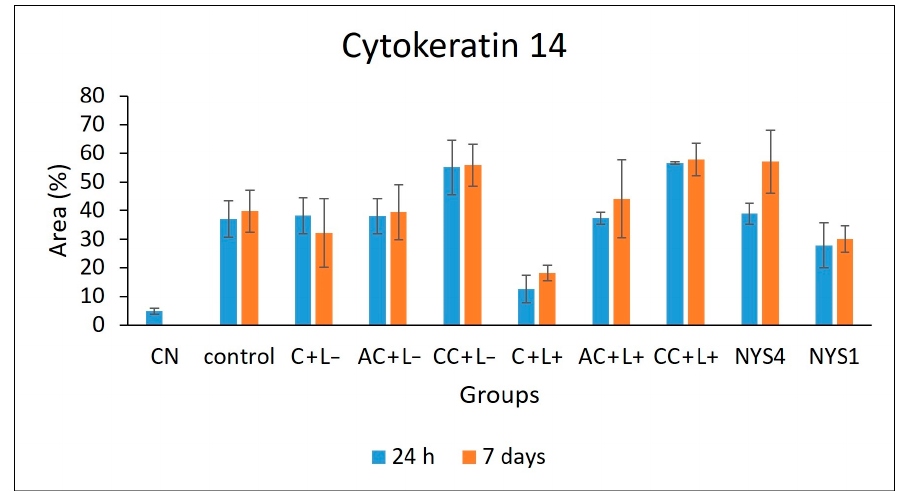
Figure 8. Mean values of CK14 immunolabelling area measured by ImageJ software ( n = 2). NC group: healthy and untreated animals; control group: infected animals that did not receive any treatment (C − L − ); C + L+, AC + L+, and CC + L+ groups: animals treated with aPDT mediated by free CUR, anionic and cationic CUR-NP, respectively, and blue LED light; C + L − , AC + L − , and CC + L − groups: evaluation of each PS alone (free CUR, and anionic and cationic CUR-NP, respectively); NYS1 and NYS4 groups: animals treated with Nystatin 100,000 IU once (under anesthesia) and four times daily, respectively. Error bars: standard deviation.